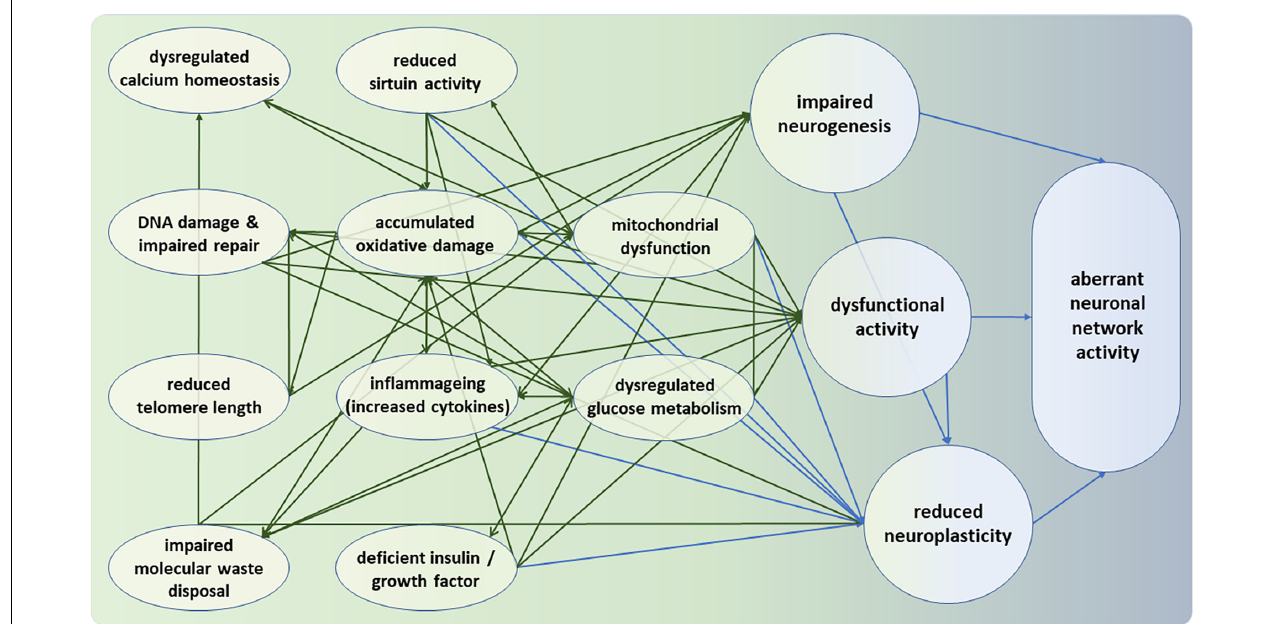
FIGURE 1 | Intra-neural and inter-neural hallmarks of neuronal deterioration. Moving from left (green) to right (blue), the hallmarks represent deficiencies at the molecular, cellular, and neuronal network levels. All intra-neural hallmarks are densely interconnected. It can be seen that the bridge between intra- and inter-neuronal hallmarks of aging appears to be formed by the three nodes of impaired neurogenesis, dysfunctional neural activity, and reduced neuroplasticity. Note that the hallmarks and their interconnections are intended to be representative but not necessarily exhaustive.